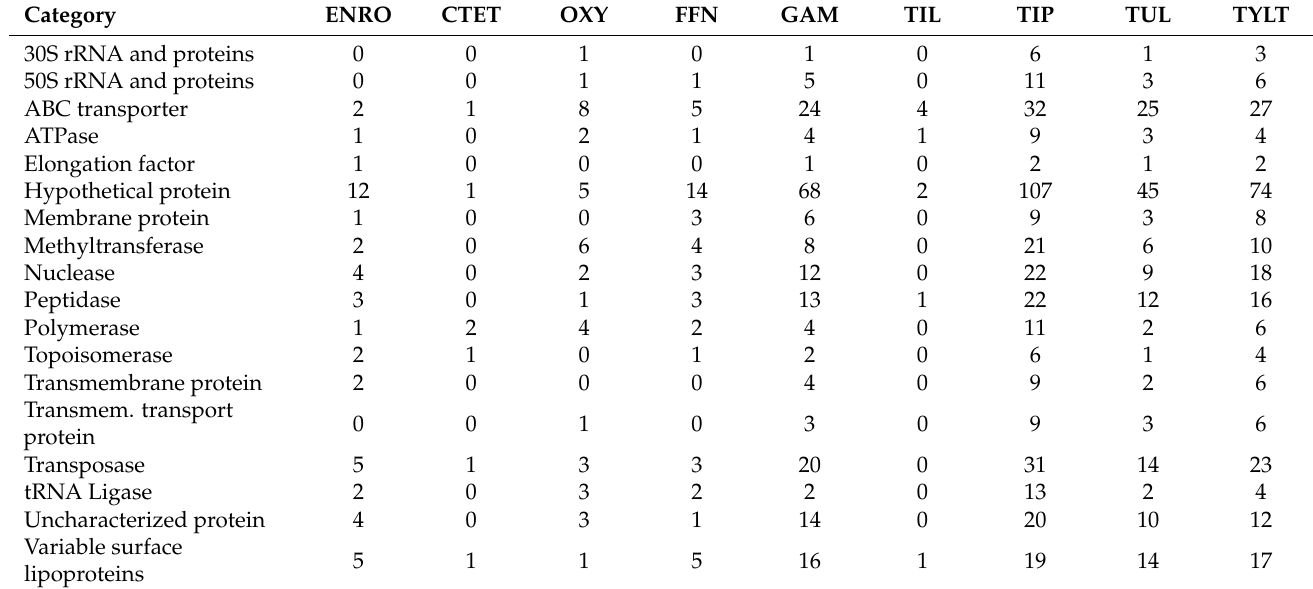
Table 1. Summary of coding sequences containing significant NVs within gene categories for each antimicrobial.